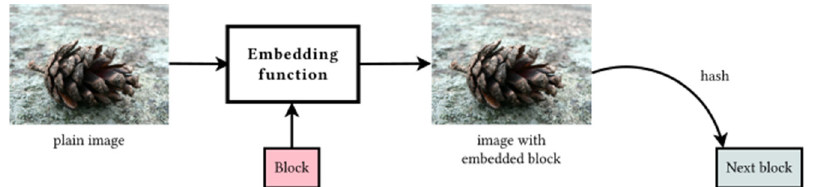
Figure 3. The role of the embedding function in the imagechain is to place data blocks into the picture. The hash of the output image is then included in the next block.